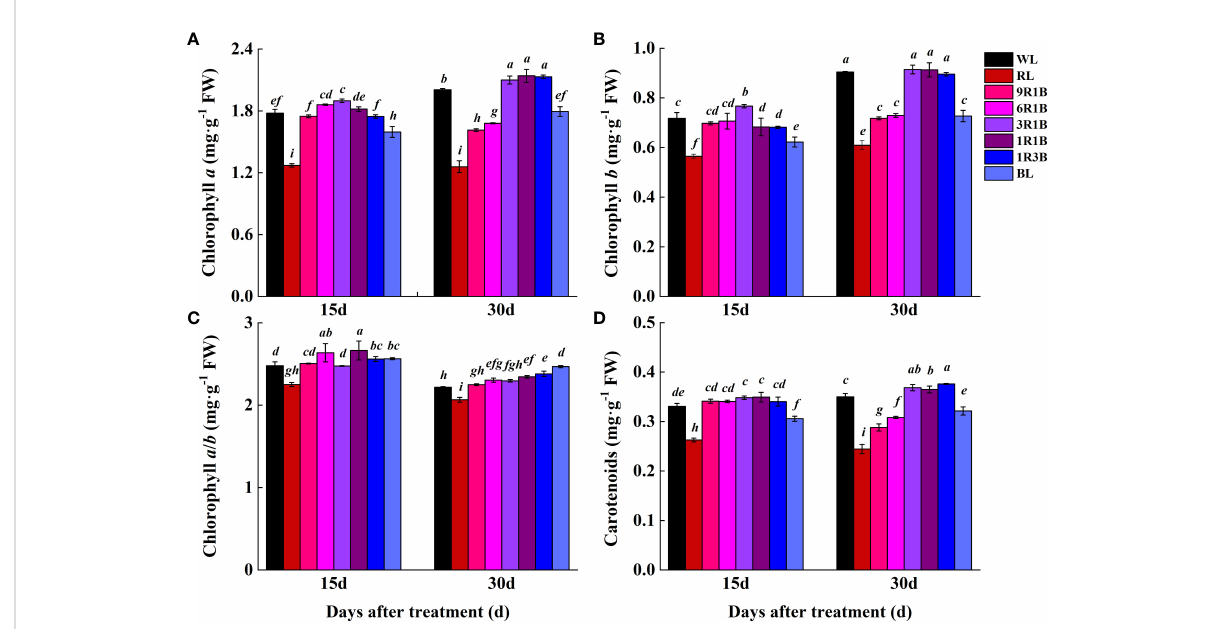
FIGURE 6 Effect of monochromatic and mixed red and blue light on photosynthetic pigment content in leaves of sweet pepper seedlings at day 15 and 30 after treatment. (A) chlorophyll a ; (B) chlorophyll b ; (C) chlorophyll a / b ; (D) carotenoids. Difference in lower-case letters indicates signi fi cant difference at P <